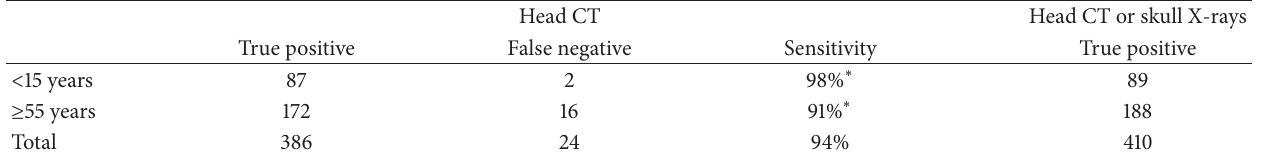
Table 3: Number of cases with linear fractures that were not detected on head CT with 10mm thick